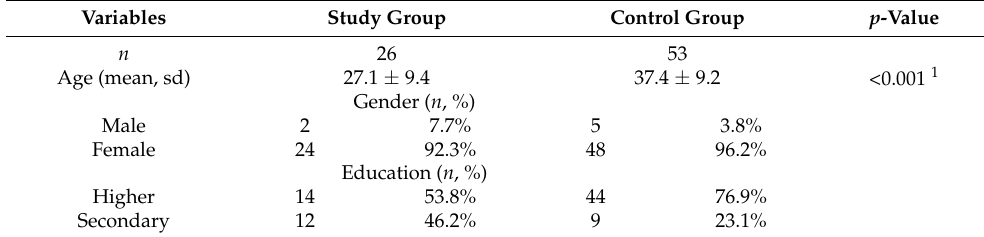
Table 1. Baseline characteristics of the participants.